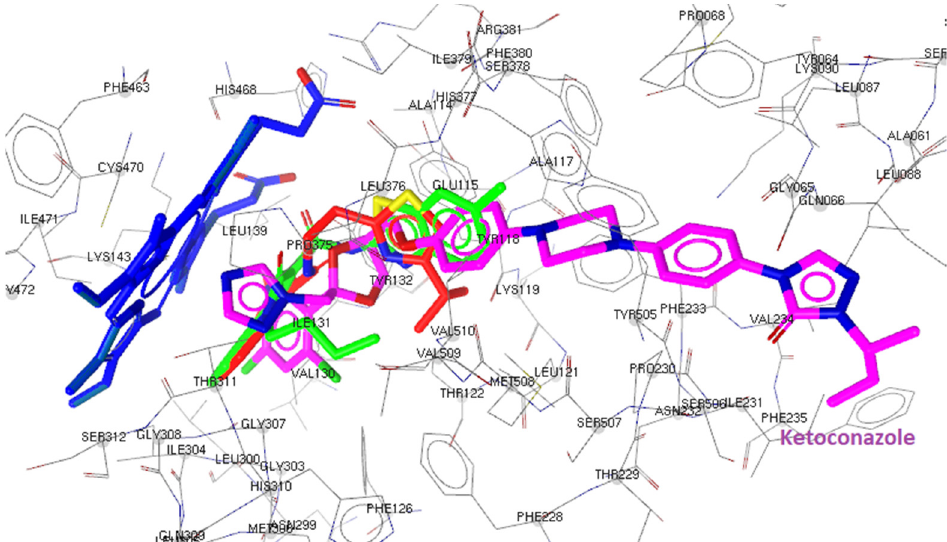
Figure 7. Superposition of compounds 9 (green), 1 (red), and ketoconazole (magenta) in lanosterol 14 α -demethylase of C. albicans (CYP51 ca ). Heme group is illustrated in blue.